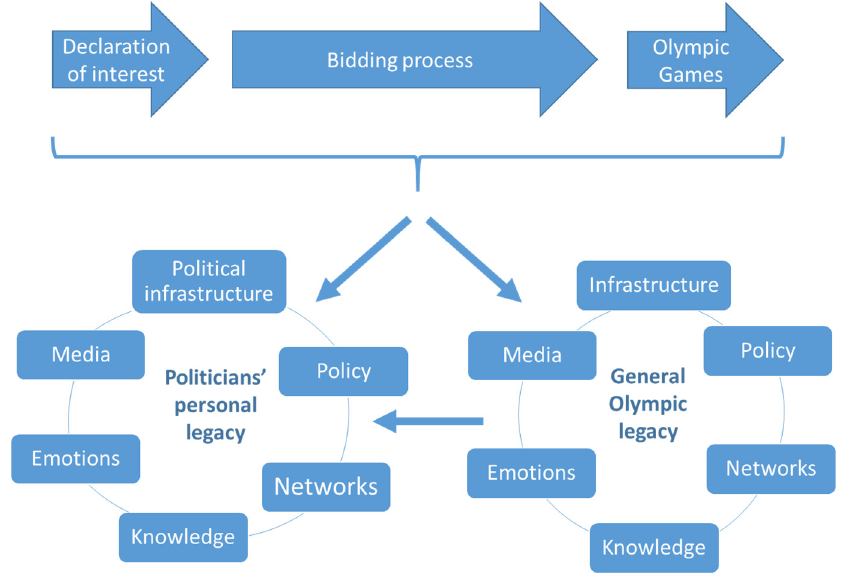
Figure 1. Sources of politicians’ personal legacies from Olympic bidding processes and Games.